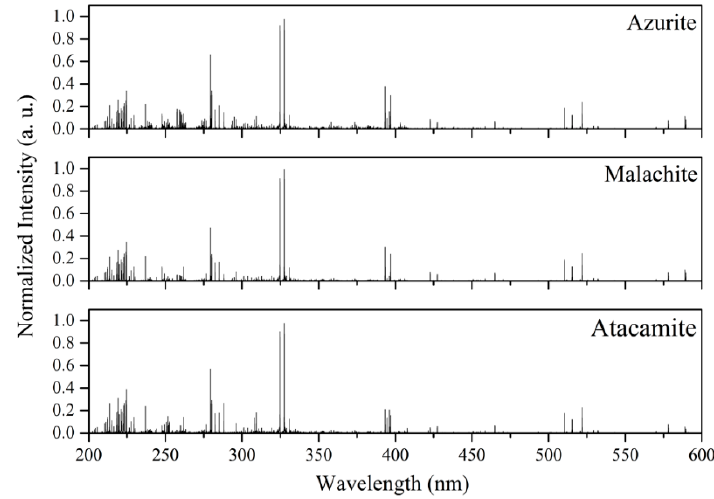
Figure 2. Characteristic spectra of three mineral pigments with Cu as the main element.